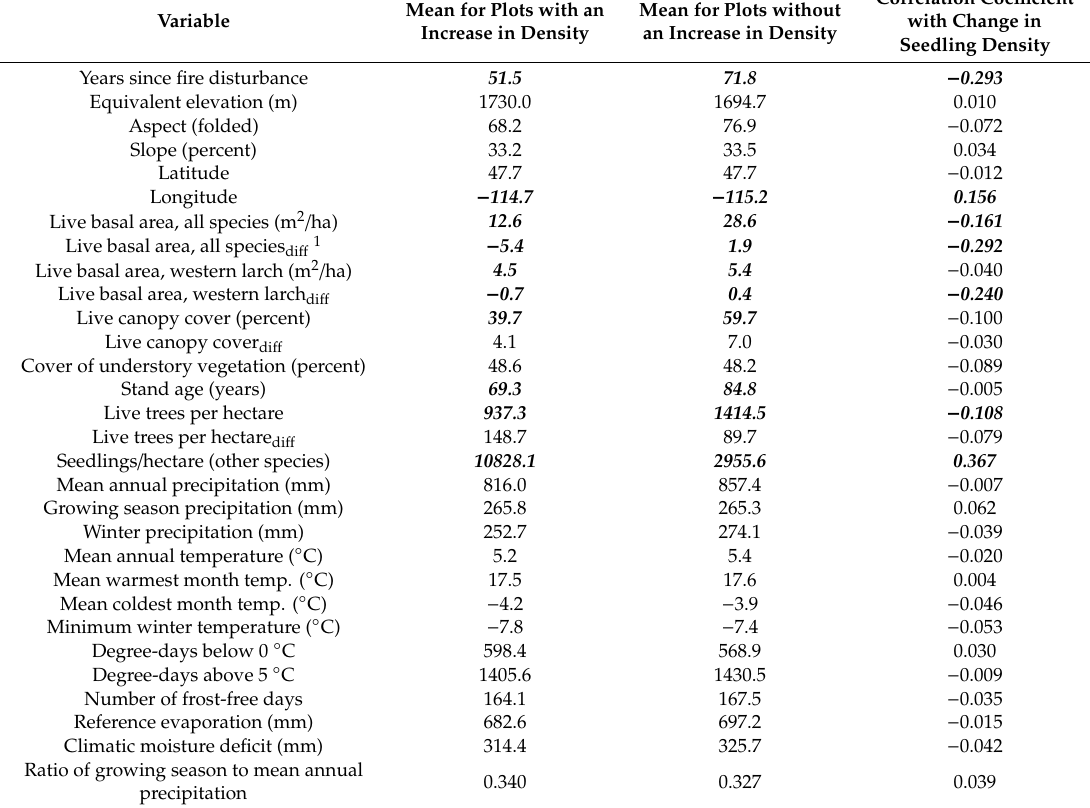
Table A3. Summary statistics of 26 continuous predictor variables for plots with and without an increase in western larch seedling density. Predictors with significantly di ff erent values between plots with and without an increase in seedling density according to Wilcoxon rank sum tests ( α = 0.05) have values in bold and italics. Significant correlation coe ffi cients ( α = 0.05) are also indicated in bold and italics. Variables are described in Table